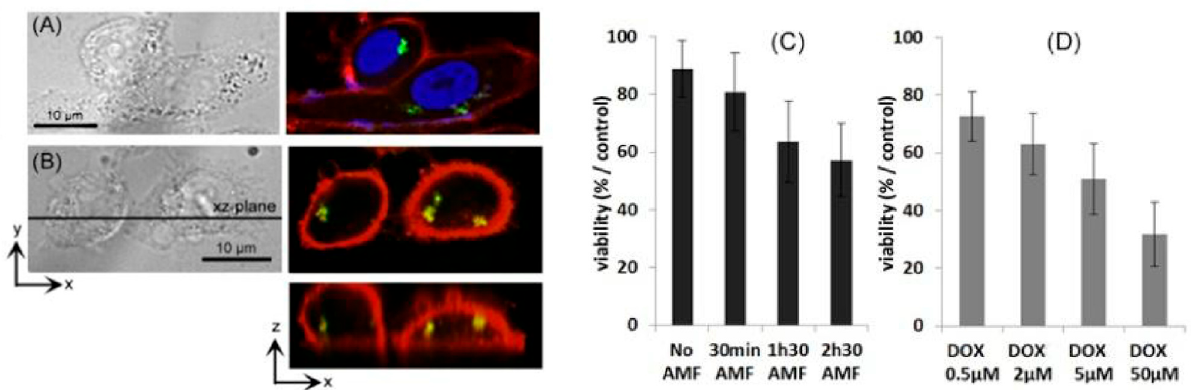
Figure 14. Cancer cells (PC-3) internalization of the Fe 2 O 3 @DOX-MIP nanoparticles. DOX is detected in the green channel, nuclei and cell membranes are stained by DAPI ( A ) in blue and PKH26 ( A , B ) in red. Z reconstructions ( B ) identify DOX inside the cells. ( C ): Viability of cancer cells labeled with Fe 2 O 3 @DOX-MIP after exposure to the alternating magnetic compared to the control experiment. ( D ) Treatment of the cancer cells with free doxorubicin (DOX) incubated for 2 h from 0.5 to 50 µM. Reproduced with permission from [109] © 2021 RSC Publishing .